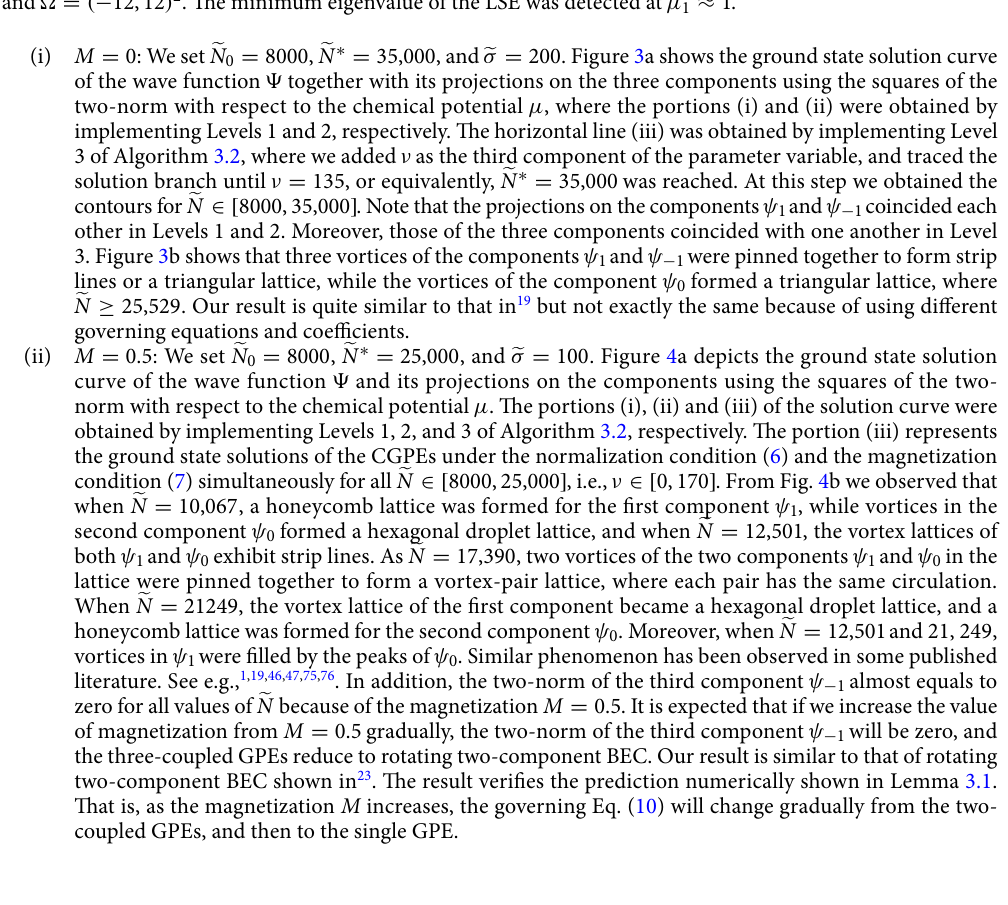
σ 200 . Figure 3a shows the ground state solution curve =